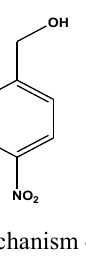
Figure 4. Preparation schematic of supported sulfonic acid on silica gel. According to the result, groups that are causing instability carbocation, reduce reaction rate. To confirm this effect, para nitro benzene alcohol reacts fridel-crafts with benzene. The results show that the reaction rate sharply decreased and the reaction was not complete even after 360 minutes (Figure 5).